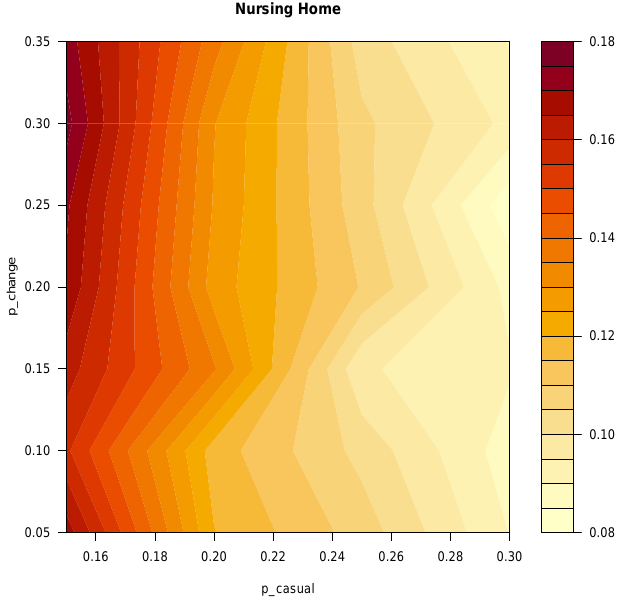
Figure 3. Heatmap representing the RMSE of the model fit for the whole facility. On the X and Y axes the explored values of p_casual and p_change